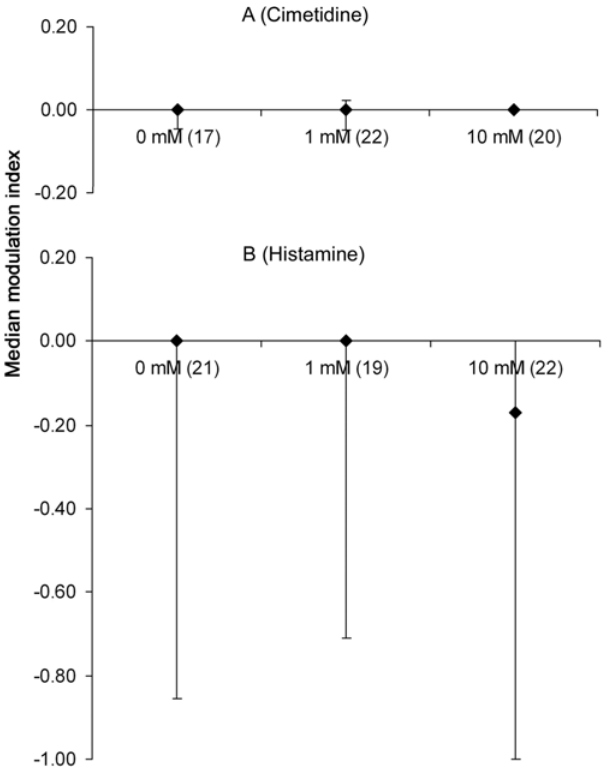
Figure 6. Effect of histaminergic drugs on sucrose sensitivity modulation index. (A) The median (50 th quantile) sucrose sensitivity modulation index (MI) for a range of concentrations of cimetidine. The modulation index corresponds to the variation that occurs in sucrose sensitivity before and after treatment (see methods). Error bars are the interquartile interval, i.e. interval between 25 th and 75 th quantiles. Note that when the 25 th and/or the 75 th quantile have the same value than the median there is no error bar to display (e.g. group cimetidine 10 mM). Numbers in parenthesis are the sample size. (B) The sucrose sensitivity modulation index for bees treated with histamine. Data are shown in the same manner as in A.